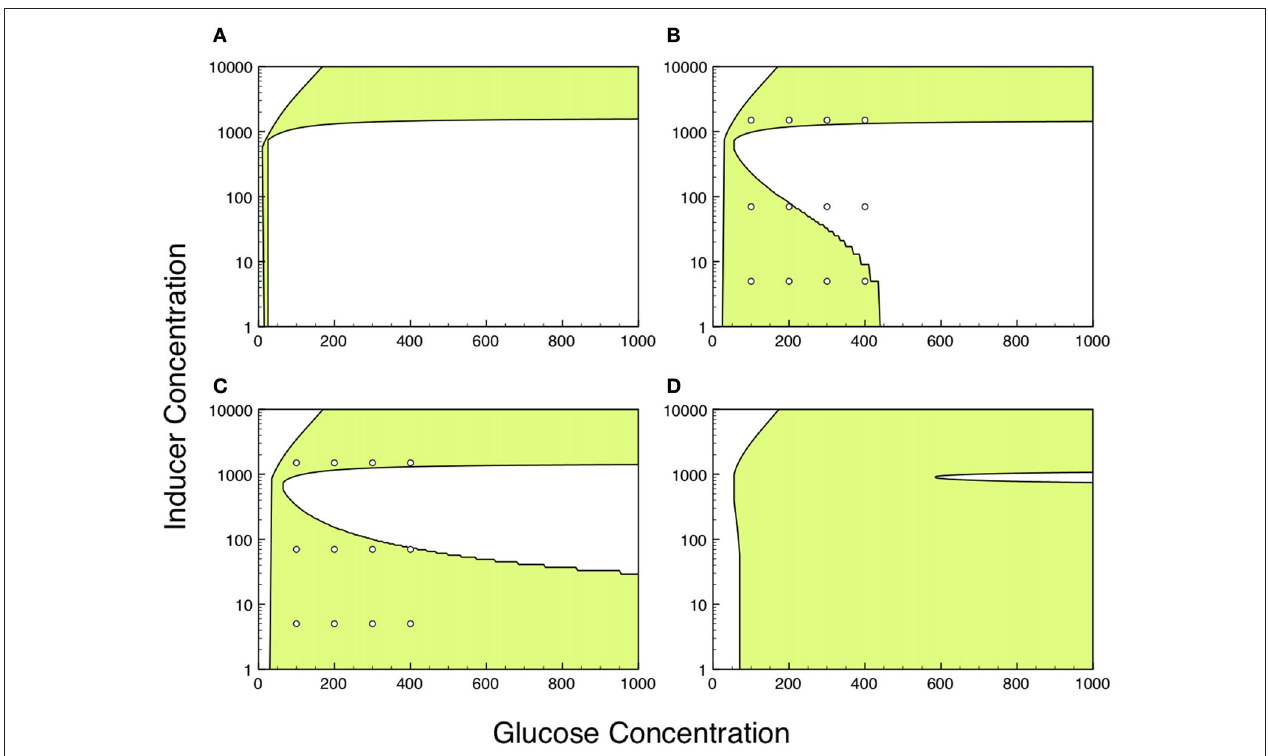
Figure 4 | Bifurcation diagrams in the [ L ] vs. [g ] parameter space, monostable induced (top) and uninduced ( bottom ) regions are uncolored. The e e calculated with the present model when the lac operon is induced open circles in graphs (B,C) denote the [ G with a mixture of lactose and TMg. [ T ] = 20 μM in (A) , [ T ] = 130 μM stochastic simulations in Figures 5 and 6 were carried out. The stair- e e in (B), [ T ] = 150 μM in (C), and [ T ] = 350 μM in (D) . In all cases, the like appearance of the borderlines is due to the resolution of our e e shaded region correspond to the bistability region, while the numerical